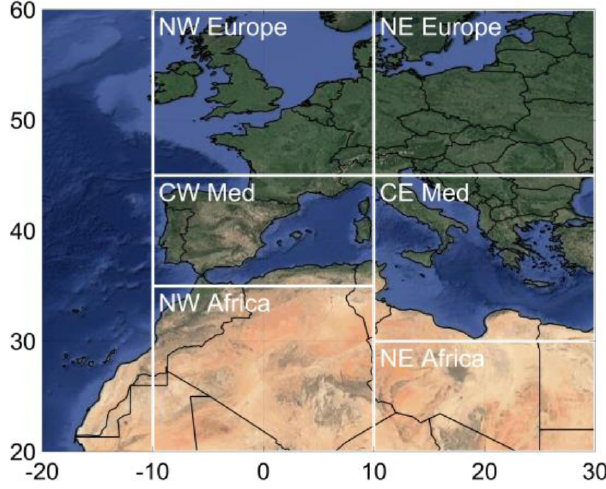
Figure 2. The six domains of the regional statistics provided on Tables 2 and